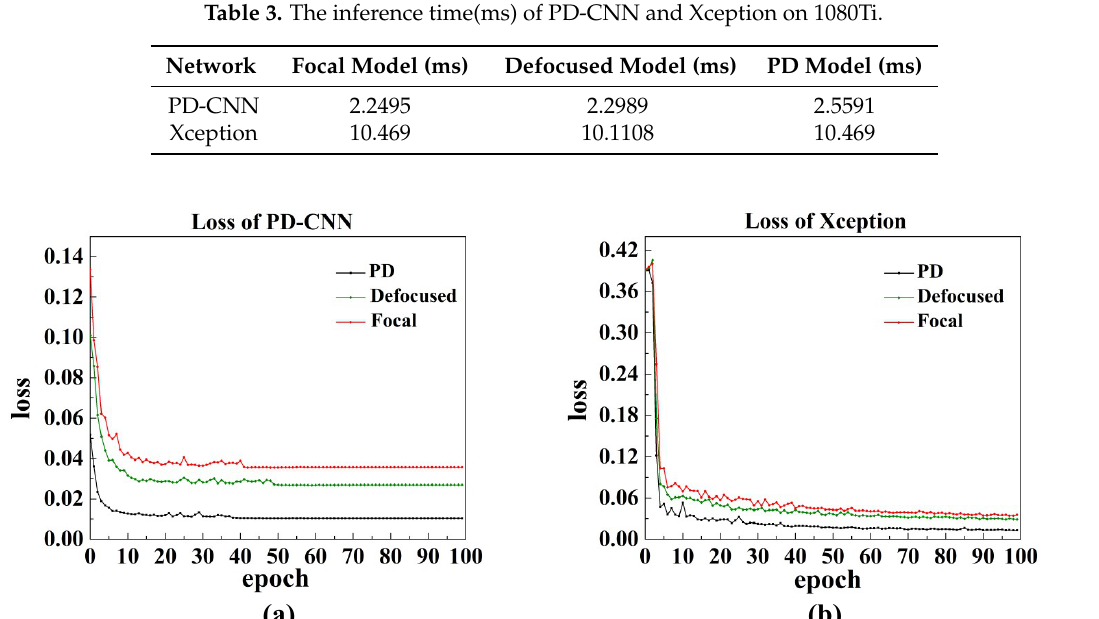
Figure 5. ( a ) The training curves of PD-CNN. ( b ) The training curves of